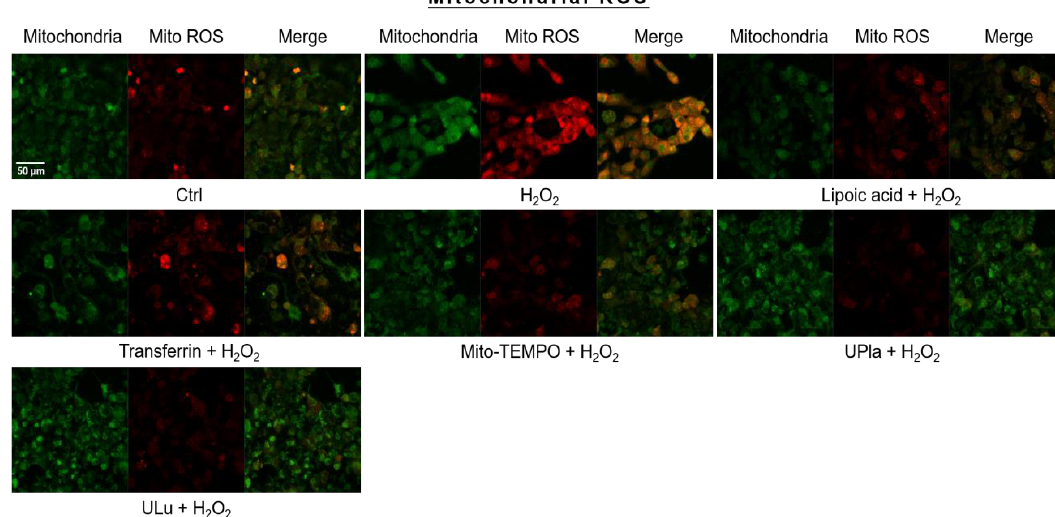
Figure 7. Mitochondrial ROS assessment with mitochondrial dye MitoTracker Green and mitochon- drial ROS indicator MitoSox Red, with visualization by confocal microscopy. The results represent similar results of three independent experiments. Mito ROS: mitochondrial